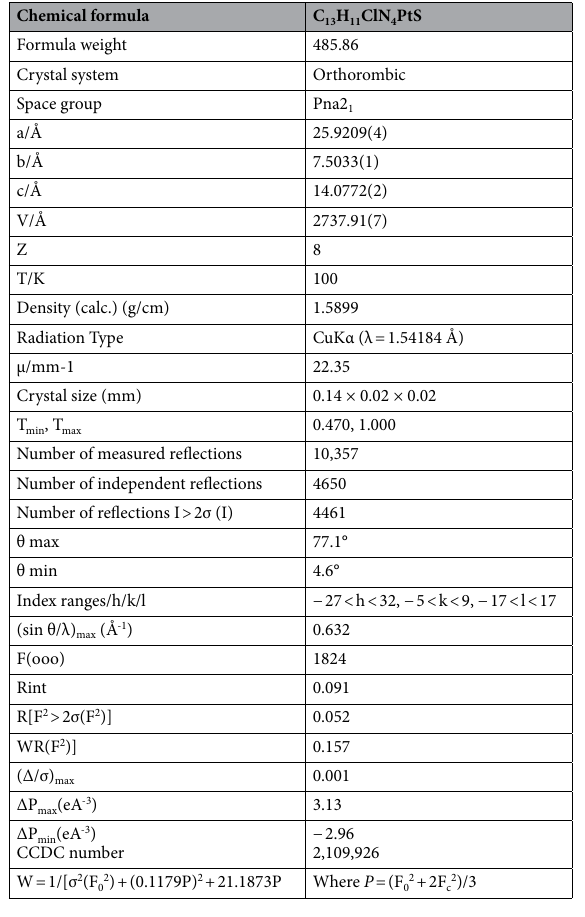
Table 2. Crystallographic data and structure refinement parameters for the complex